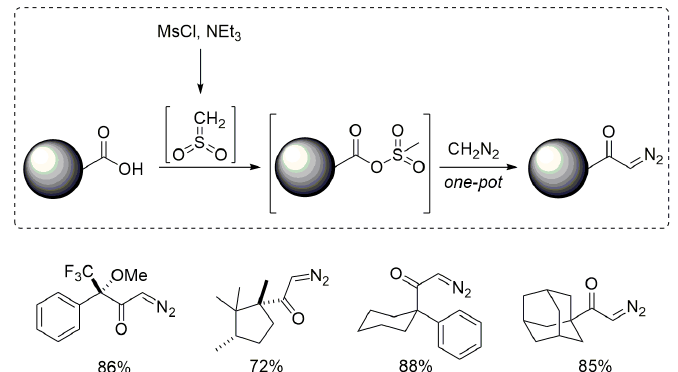
Figure 9 - Synthesis of highly hindered diazoketone by Nicolaou and co-